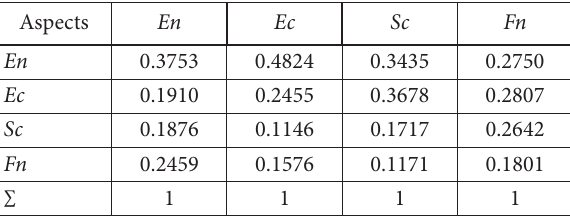
Table 7. Normalized matrix for sustainability